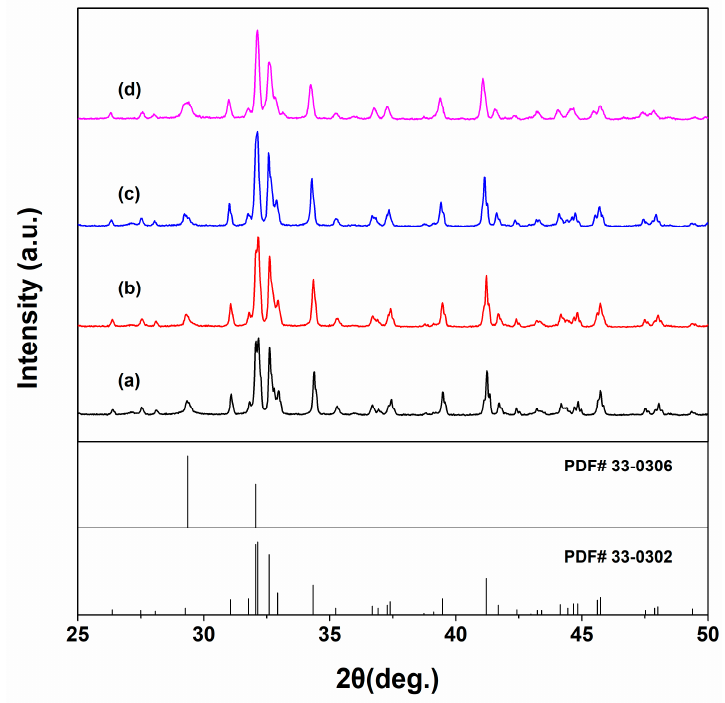
Figure 4. XRD patterns of C2S and Sr-C2S bone cements after curing in a constant-temperature shaking water bath at 37 °C for 14 days: ( a ) C2S; ( b ) Sr1-C2S; ( c ) Sr5-C2S; ( d ) Sr10-C2S. PDF# 33-0302 and 33-0306 are standard diffraction data of C2S and CSH, respectively. The XRD patterns of C2S and Sr-C2S bone cements are consistent with that of C2S (PDF# 33-0302). The diffraction peaks of CSH (PDF# 33-0306) overlap with those of C2S.